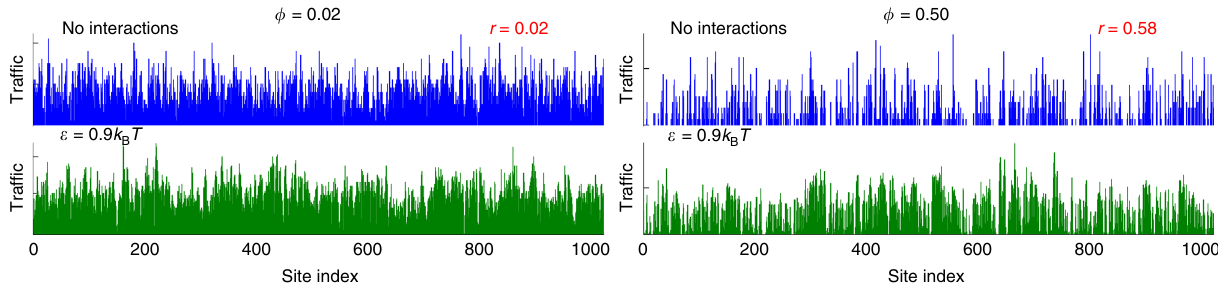
Fig. 5 Traf fi c with and without tracer – polymer interactions. In blue: traf fi c of tracers without tracer – polymer interactions, i.e., interacting only through hard- core repulsion. In green: traf fi c of tracers with tracer – polymer af fi nity equal to 0.9 k B T . Left: low compaction with ϕ = 0.02. Right: high compaction with ϕ = 0.50. Values of the Pearson correlation coef fi cient between the polymer occupancy and the tracer traf fi c are reported in red